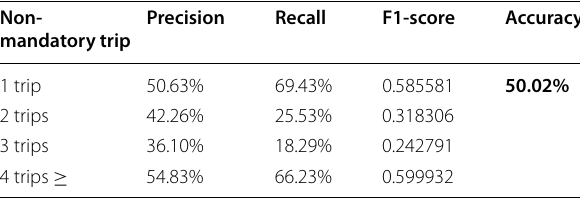
Table 6 The evaluation metrics of non-mandatory trips